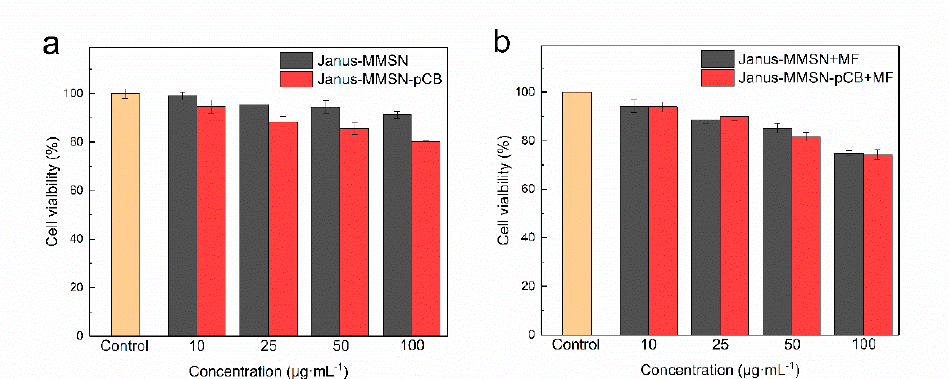
Figure 4. In vitro cytotoxicity of Janus-MMSN and Janus-MMSN-pCB to Calu-3 cells without a magnetic field ( a ) or with a magnetic field ( b ). (The magnetic field strength is 20 mT, with a gradient of 2